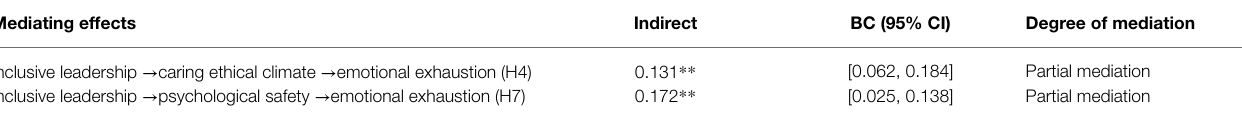
TABLE 4 | The mediating effect of the